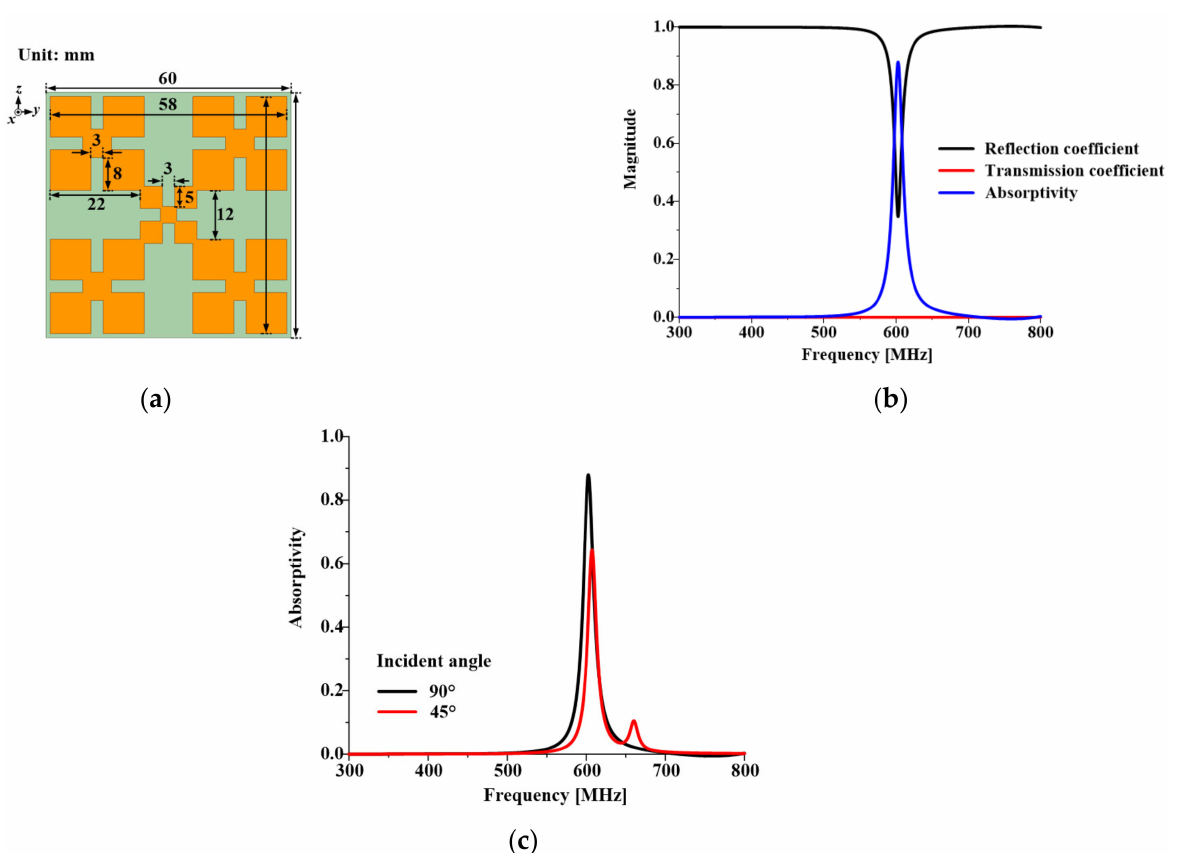
Figure 14. Optimized unit cell of fractal absorber: ( a ) geometry of optimized unit cell, ( b ) simulated S-parameters and absorptivity, and ( c ) simulated absorptivity performances depending on incident